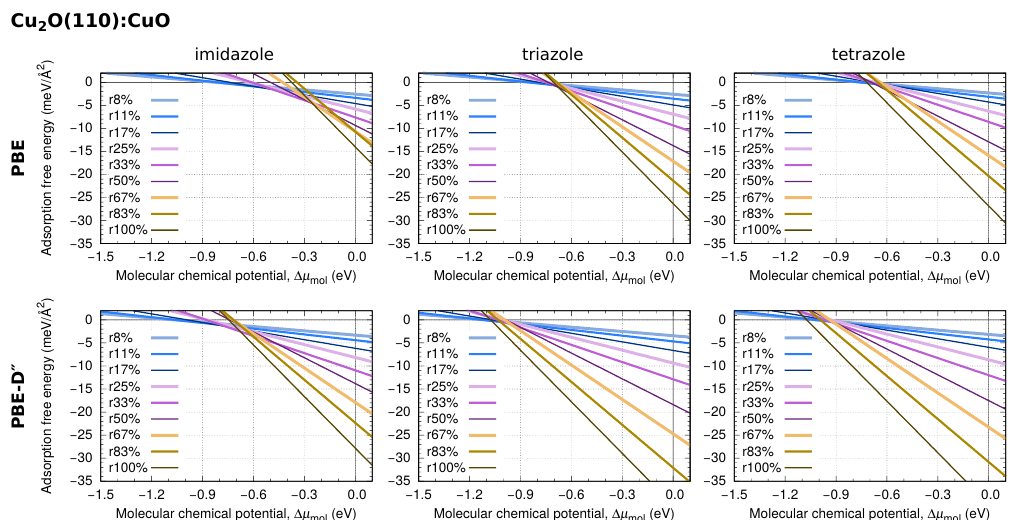
√ √ 3 × 3) R 30 ◦ ( top ) and Cu 2 O(110):CuO ( bottom ). √ √ 3 × 3) R 30 ◦ up to a coverage of r 33% (marked as